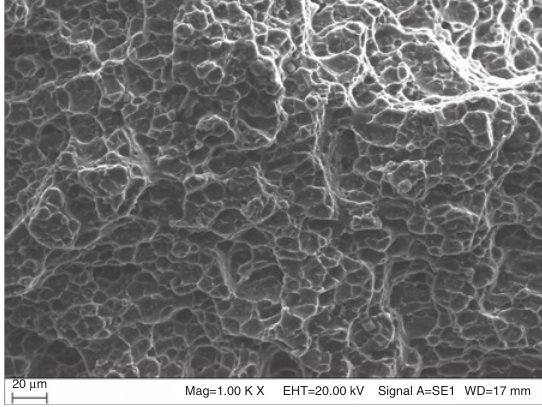
Figure 17 SEM image of the fracture surface of the N6 sample.